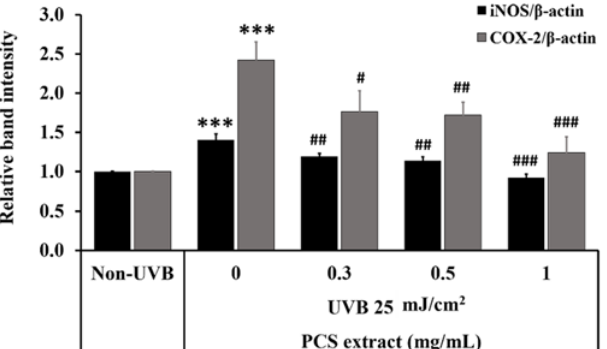
Figure 4. Inhibitory effect of PCS extract on UVB-induced proinflammatory cytokines in HaCaT cells. Cells were pre-treated with PCS extract for 1 h before UVB irradiation. After 24 h, cells lysates were analyzed by Western blot analysis. The histogram presents the relative band intensity of iNOS and COX-2 protein expression after normalization with the internal control ( β -actin). Results are the mean average ± SD ( n = 3). *** p < 0.001 vs. the non-UVB group and # p < 0.05; ## p < 0.01; ### p < 0.001 vs. the UVB control group.